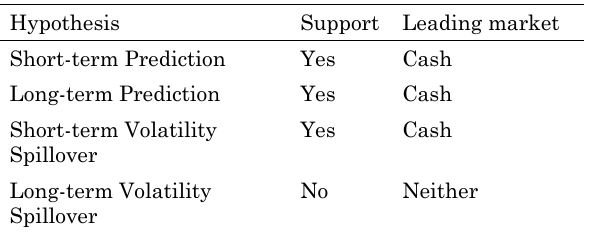
table 3. Summary results table for the full sample